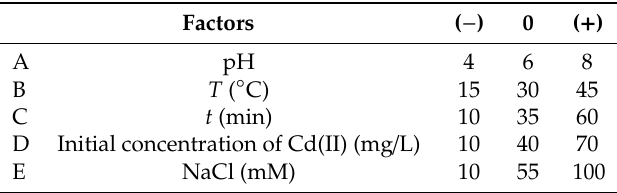
Table 2. Experimental design matrix of the 2 5 − 1 fractional factorial design (FFD) with resolution V.